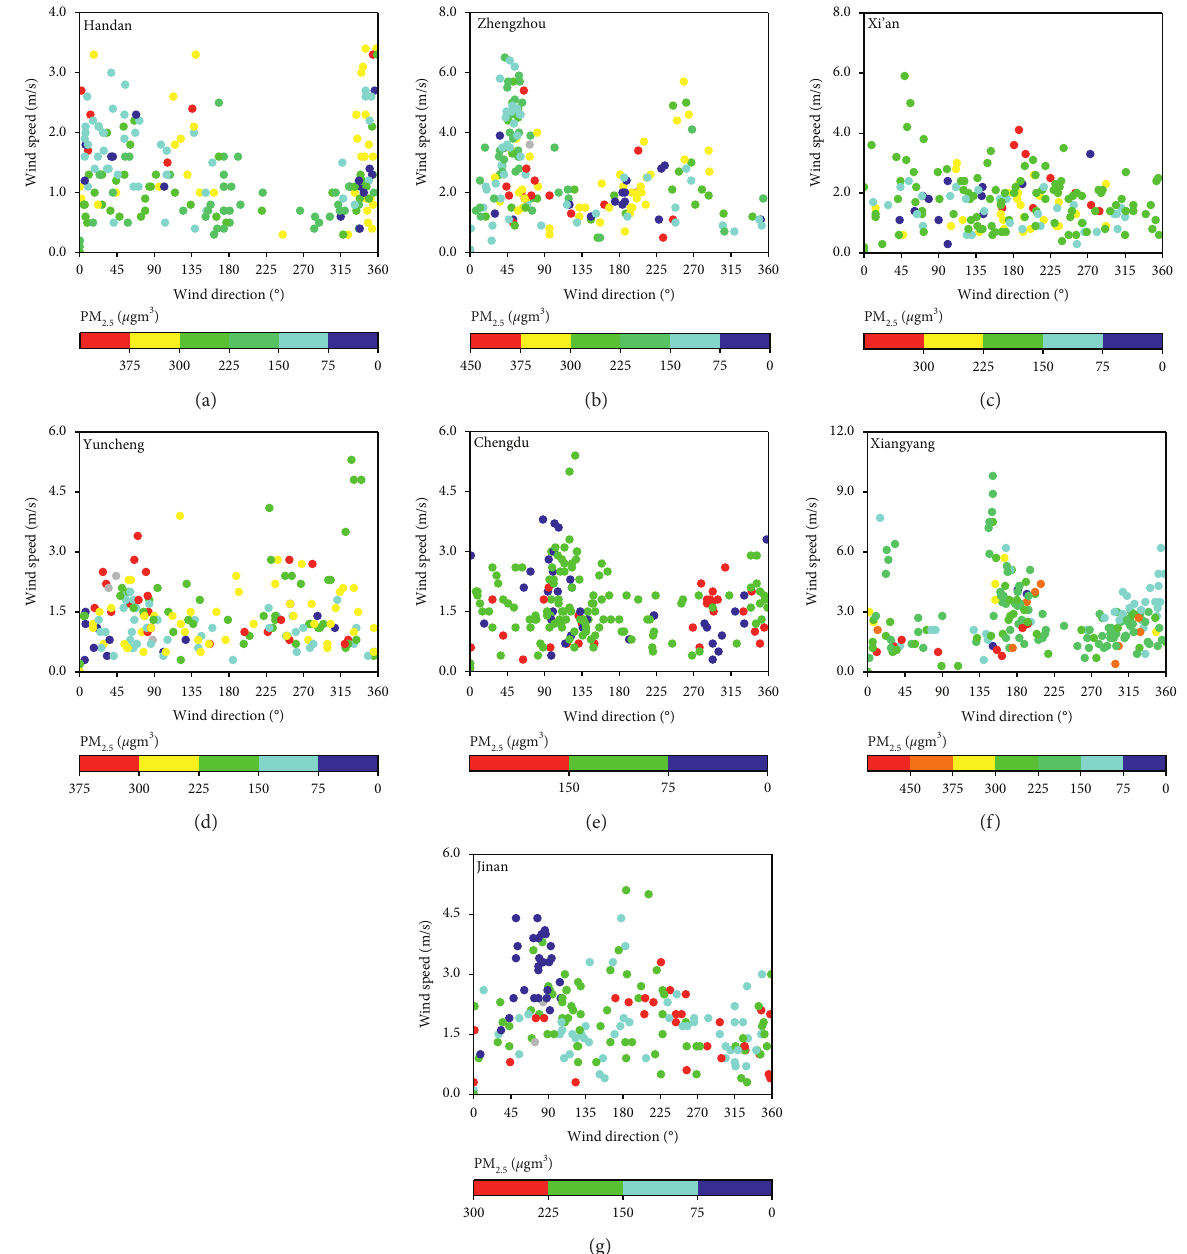
Figure 6: Distribution of PM 2.5 concentrations with observed hourly wind direction and speed in each direction in seven Chinese